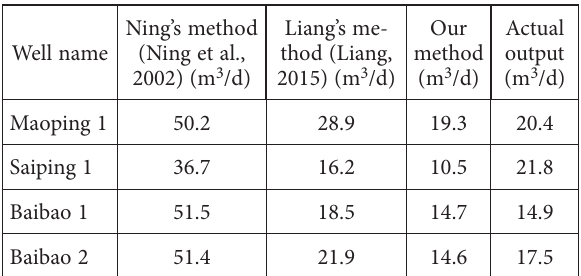
Table 5. Statistics of productivity prediction